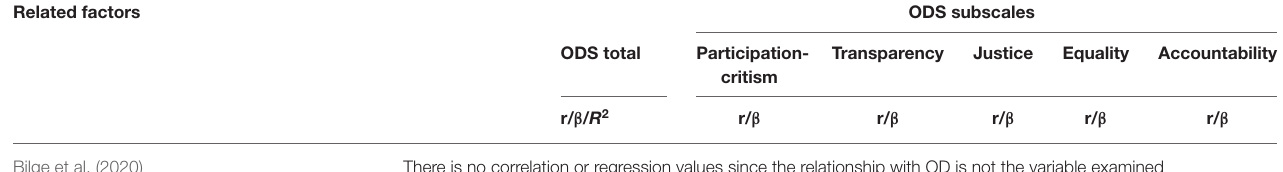
TABLE 5 | The correlations and regression of related factors with ODS total and subscales (studies with different scale structures). Related factors